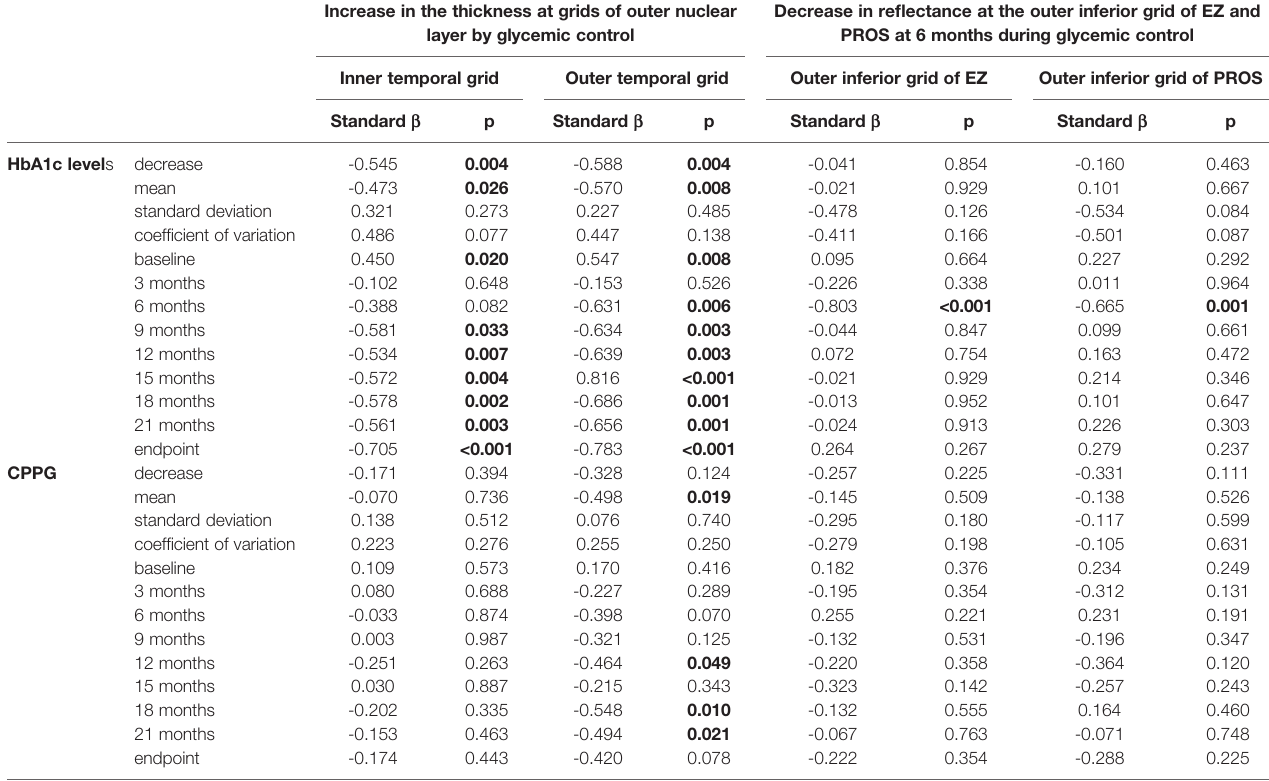
TABLE 3 | Correlations between the increase in the thickness at grids of the outer nuclear layer or the decrease in re fl ectance at EZ and PROS grids and parameters of HbA1c, CPPG, and their variability during the follow-up period in patients with type 2 diabetes undergoing glycemic control for 24